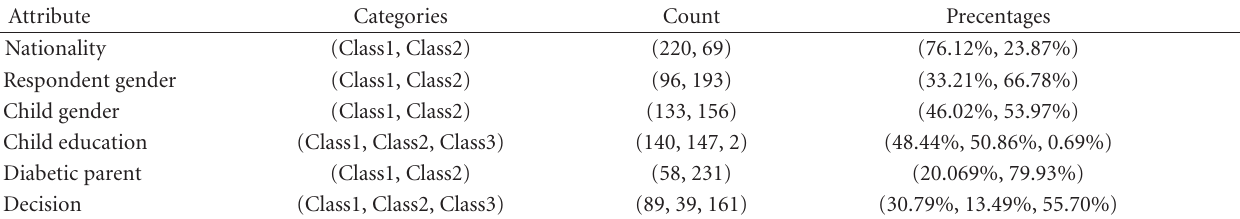
Table 4: Attribute distribution within the classes.